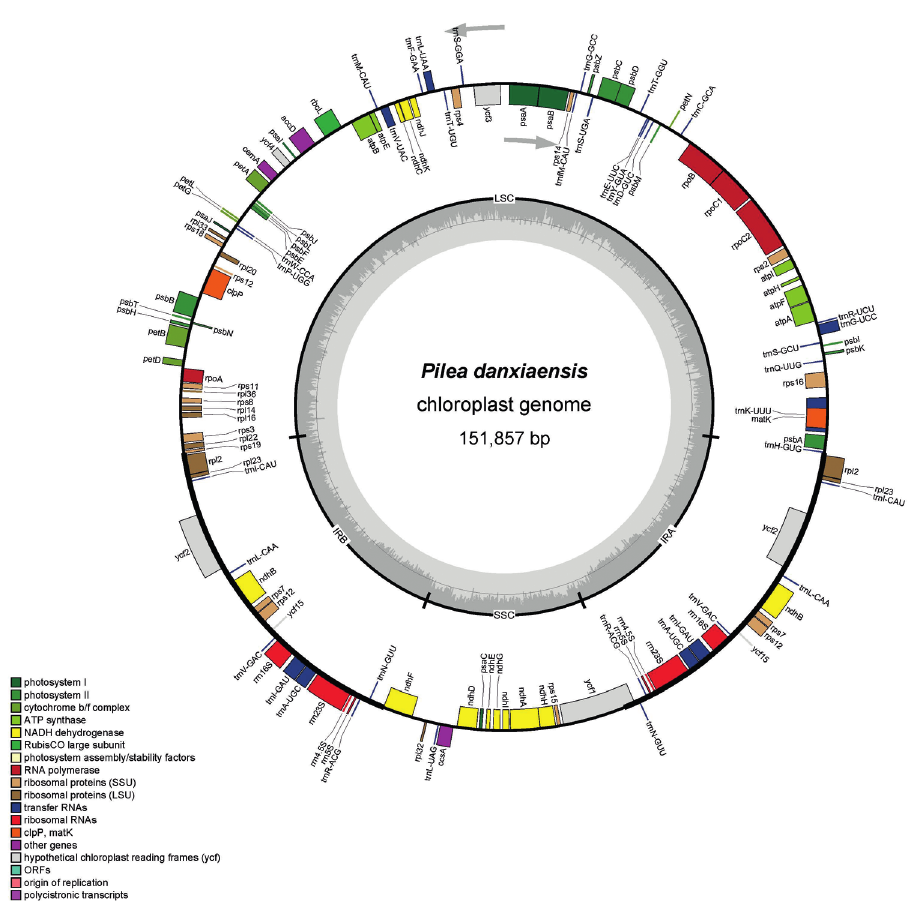
Figure 1. Plastid genome map of Pilea danxiaensis . The thick lines on the outer complete circle identify the inverted repeat regions (IRa and IRb). The innermost track of the plastome shows the GC content. Genes on the outside and inside of the map are transcribed in clockwise and counter directions,